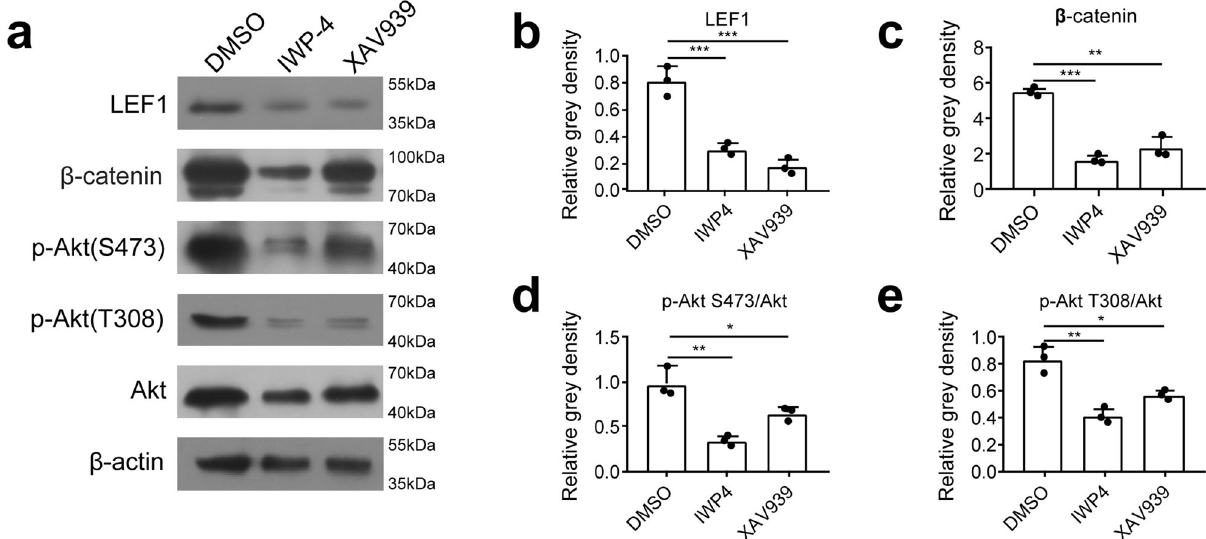
Fig. 5 Akt phosphorylation was inhibited by Wnt antagonist during tail regeneration. a Protein content of LEF1, β -Catenin and p-Akt (Ser473, Thr308) in tail tissues from Wnt inhibition groups (IWP-4 and XAV939) were signi fi cantly reduced compared with that control (DMSO) group. b – e Relative level of proteins in Fig. 5a. Values represent mean ± SD, N = 3, ns p > 0.05, * p < 0.05, ** p < 0.01, *** p < 0.001.